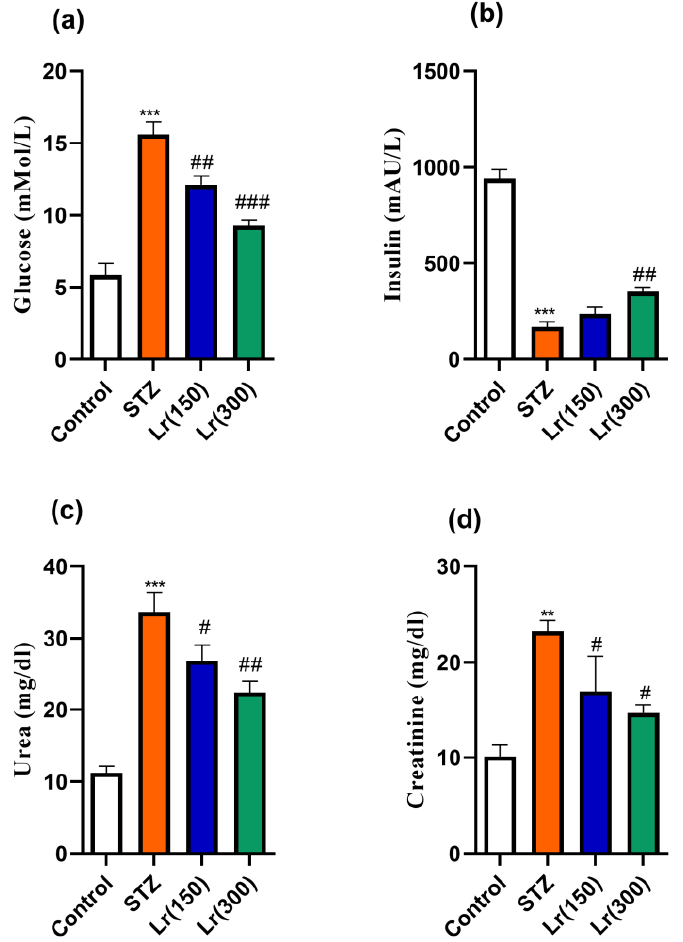
Figure 1. Effect of L. regularis (150 or 300 mg/kg for 4 consecutive weeks) on diabetic-induced changes in serum glucose ( a ), insulin ( b ), urea ( c ) and creatinine ( d ) levels. Data are expressed as means ± SE ( n = 6) and were analyzed using one-way ANOVA followed by Student Newman–Keuls as post hoc test. * Control vs. STZ group; # STZ vs. L. regularis (150) or L. regularis (300). # p < 0.05, ** or ## p < 0.01, *** or ### p < 0.001. Serum lipid parameters, including TC, triglycerides (TG) and LDL-cholesterol lev- els were significantly increased in STZ-injected rats compared to control rats ( p < 0.001) (Figure 2a–c). The serum HDL-cholesterol levels were not significantly affected (Figure 2d). Serum TC and TG levels were significantly reduced in L. regularis (150 or 300 mg/kg/day)- treated groups compared to STZ- and vehicle-treated group ( p < 0.05 and p < 0.05, respec- tively) (Figure 2a,b). Similarly, LDL-cholesterol levels were also significantly reduced in L. regularis (150 or 300 mg/kg/day)-treated groups compared to STZ- and vehicle-treated group ( p < 0.01 and p < 0.001, respectively) (Figure 2c). However, serum HDL-cholesterol levels were not significantly altered in L. regularis (150 or 300 mg/kg/day)-treated groups compared to the STZ- and vehicle-treated group (Figure